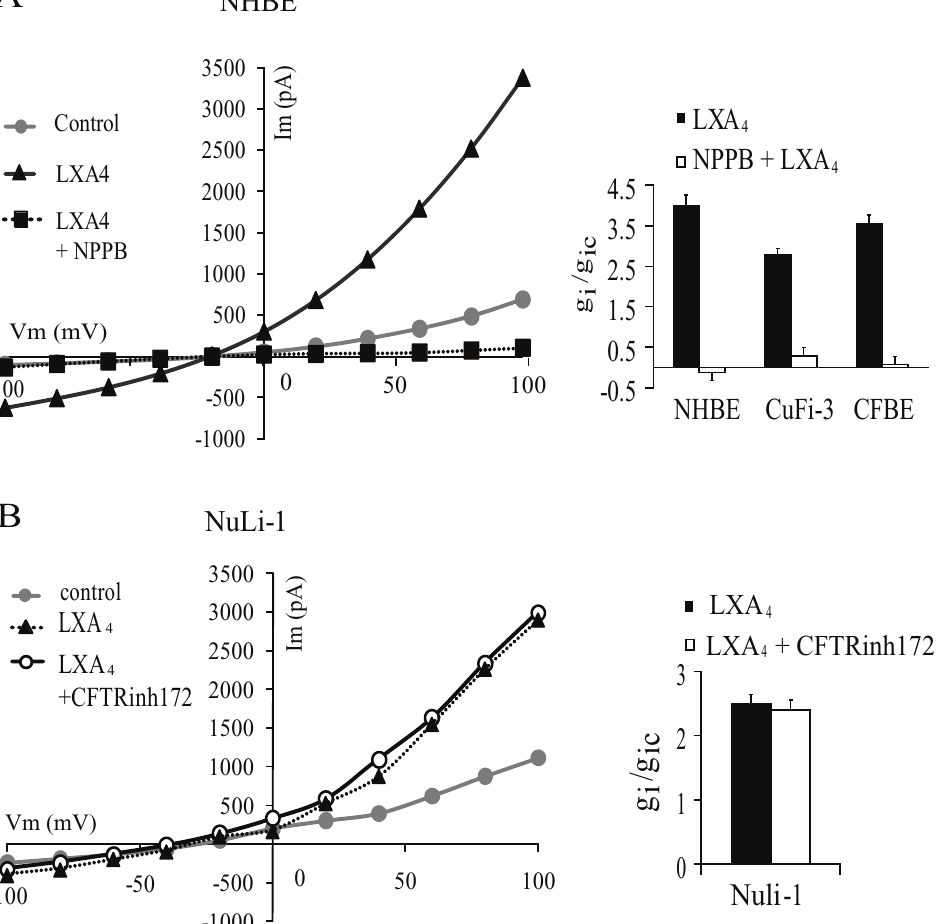
Figure 5. Effects of Cl 2 channel inhibitors on whole-cell currents stimulated by LXA 4 . (A) Representative I-V relationship of the effect of NPPB (1 m M) after the stimulation of primary cultures of bronchial epithelial cells with LXA 4 (100 nM). Corresponding histogram of the inhibitory effect of NPPB on the inward conductance obtained in non-CF primary NHBE cells (n=4), CuFi-3 cells (n=3) and CF primary CFBE cells (n=3) after stimulation with LXA 4 (100 nM, 10 min). (B). Typical I-V relationships of the effect of LXA 4 (100 nM) obtained in NuLi-1 cells after treatment with the CFTR channel inhibition CFTR-inh172 (5 mM) and histogram showing the absence of inhibitory effect in Nuli-1 cells